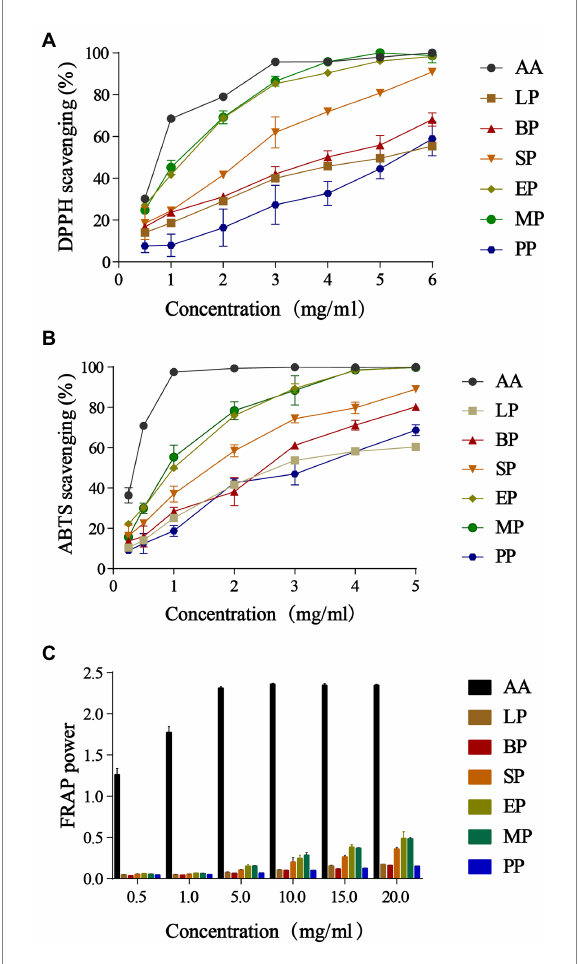
FIGURE 1 DPPH radicals scavenging activities (A) ; ABTS radicals scavenging activities (B) and ferric reducing antioxidant power (C) . Data are reported as the mean value ± standard deviation of three